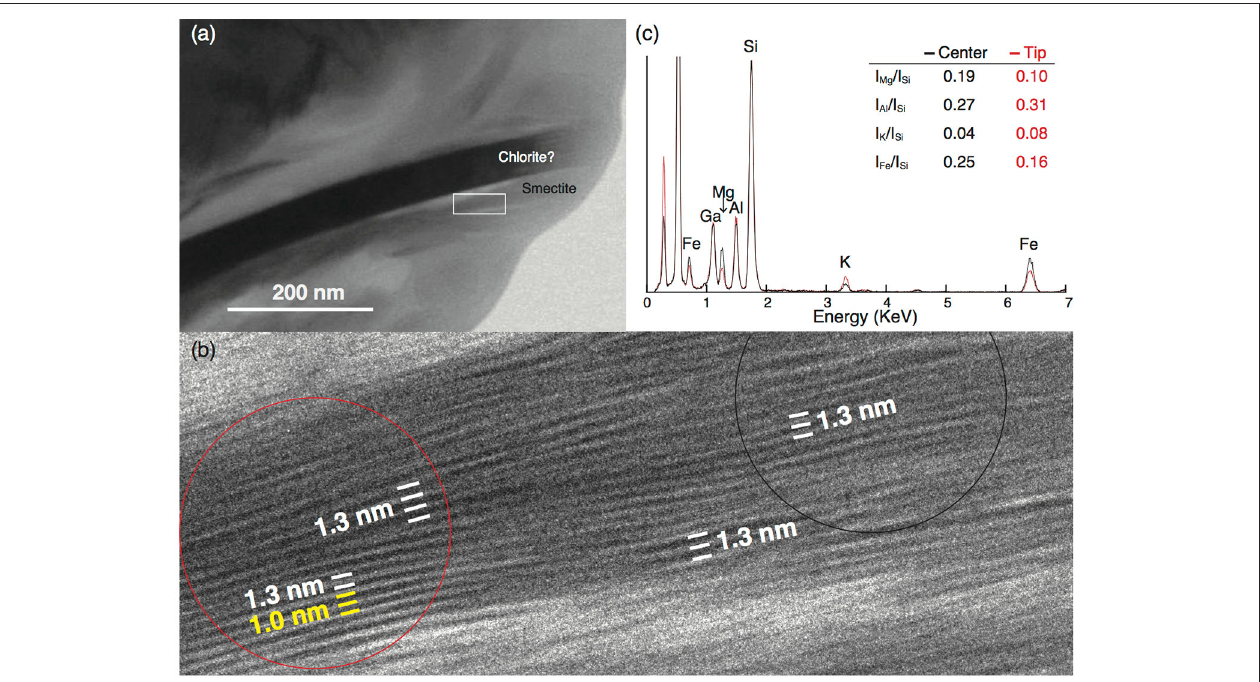
FIGURE 9 | TEM micrograph of a smectite particle in sample 28H-5w-70-71cm (267.7 mbsf) from Site U1343. (a) Small smectite particles near a chlorite particle; the white rectangle outlines the area shown in (b) . (b) High-resolution TEM lattice fringe image showing that smectite (interlayer spacing 1.3nm) is partly transformed into illite (1.0nm). Red and black circles outline the areas in the tip and central parts, respectively, that were analyzed by energy-dispersive X-ray spectroscopy (EDS). (c) EDS spectra of the tip (red line) and center (black line) of the smectite particle with the ratio of X-ray counts for each element. The intensities of Si peaks were matched to normalize the two spectrums. The Ga peak is an artifact of the Ga-ion beam used during the preparation of the ultrathin foil.